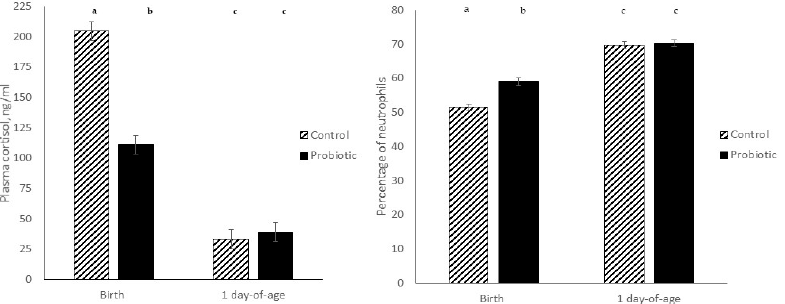
Figure 1. Effect of prenatal maternal treatment on plasma cortisol concentrations ( left ) and percentage of neutrophils ( right ) of piglets at birth and 24-h later. Data are expressed as means ± SEM, and means with different letters differ at p < 0.05 (treatment × day of age).